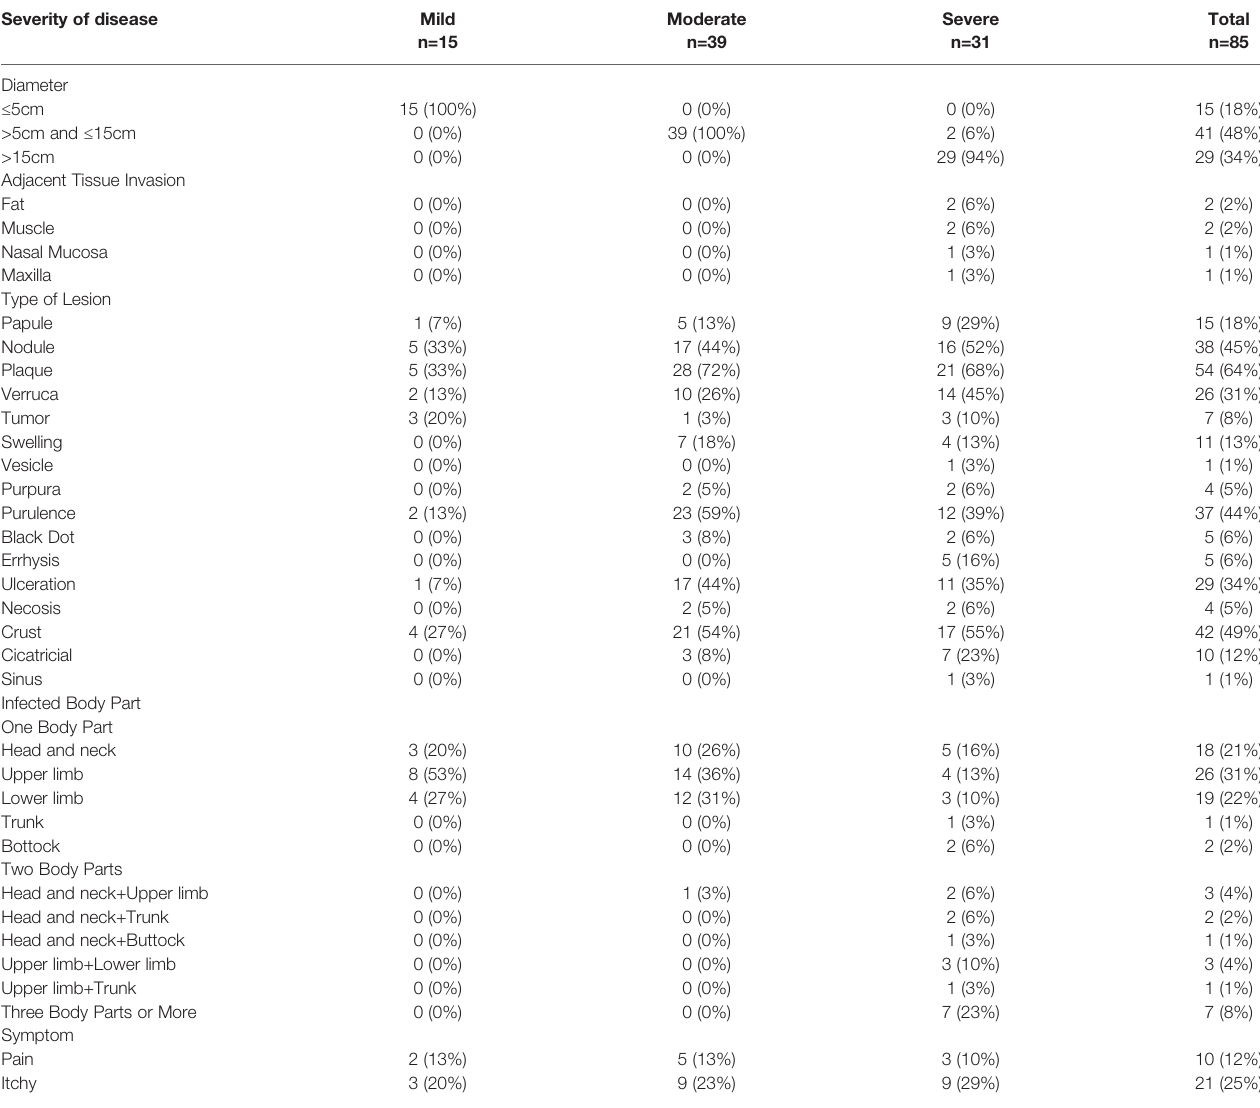
TABLE 4 | Severity gradation and clinical manifestation in patients with subcutaneous